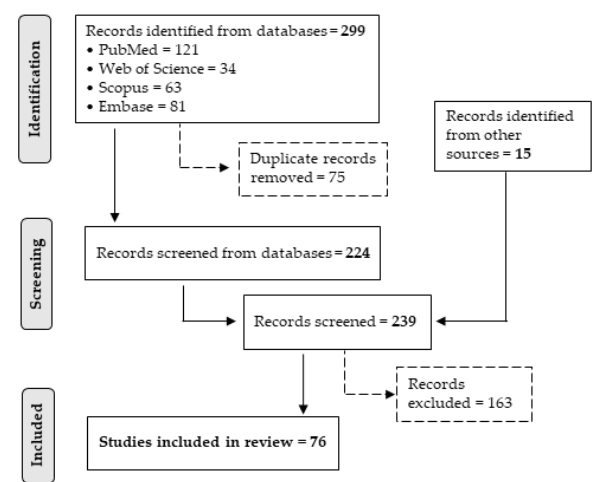
Figure 1. PRISMA flow diagram. Flowchart of the selection process for the inclusion of studies. The search identified 76 experimental studies focused on 74 cell lines. In Tables 1–3, the observed effects induced by CNF1 toxin and the related references have been grouped together for each cell type origin i.e., cancer, immortalized/trans- formed, and finite/primary.